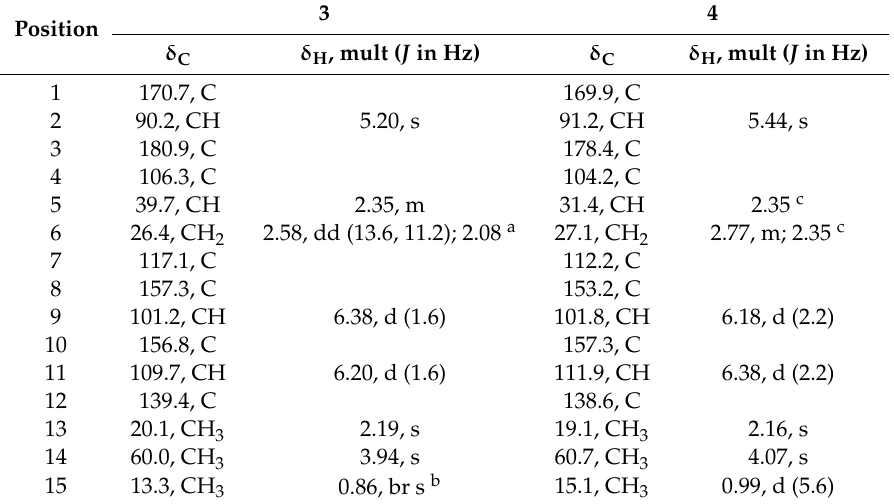
(Figure S15 and S16), implied that the C-4 anomers mutually transformed in solution. Owing to no optical rotation and no CD absorption displayed, 3 existed as an inseparable racemic mixture. Table 2. 1 H (400 MHz) and 13 C (100 MHz) NMR data for 3 and 4 in acetone- d 6 .